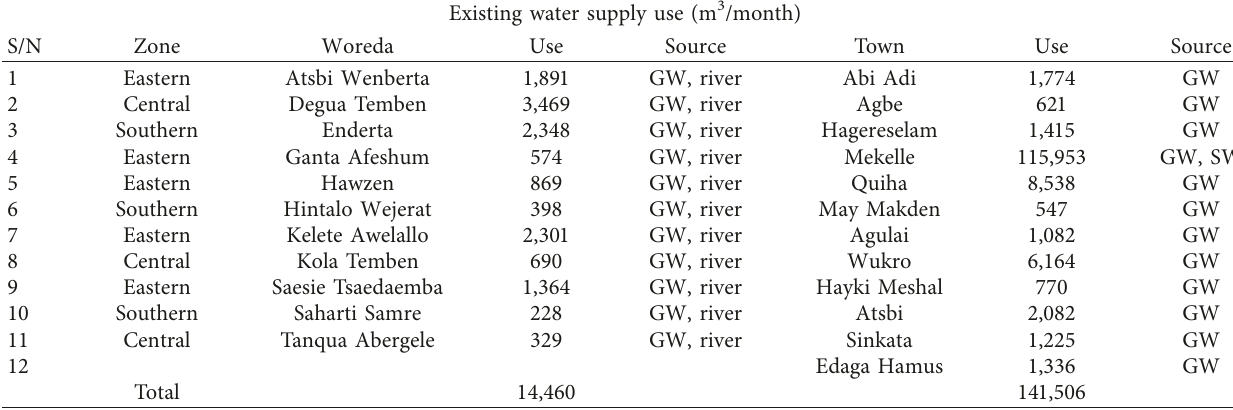
Table 7: Current commercial, public, and institutional water use of the rural and urban areas of the subbasin.